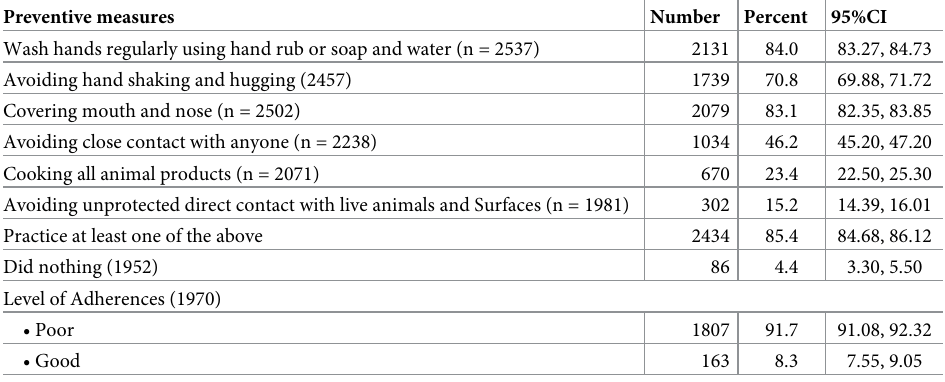
Table 4. Practices and adherences of study participants to COVID-19 preventive measures, Oromia region, Ethio- pia, September 2020 to March 2021. Preventive